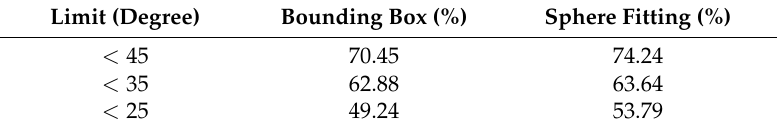
Table 4. Frequency of 3D pose error within certain angle